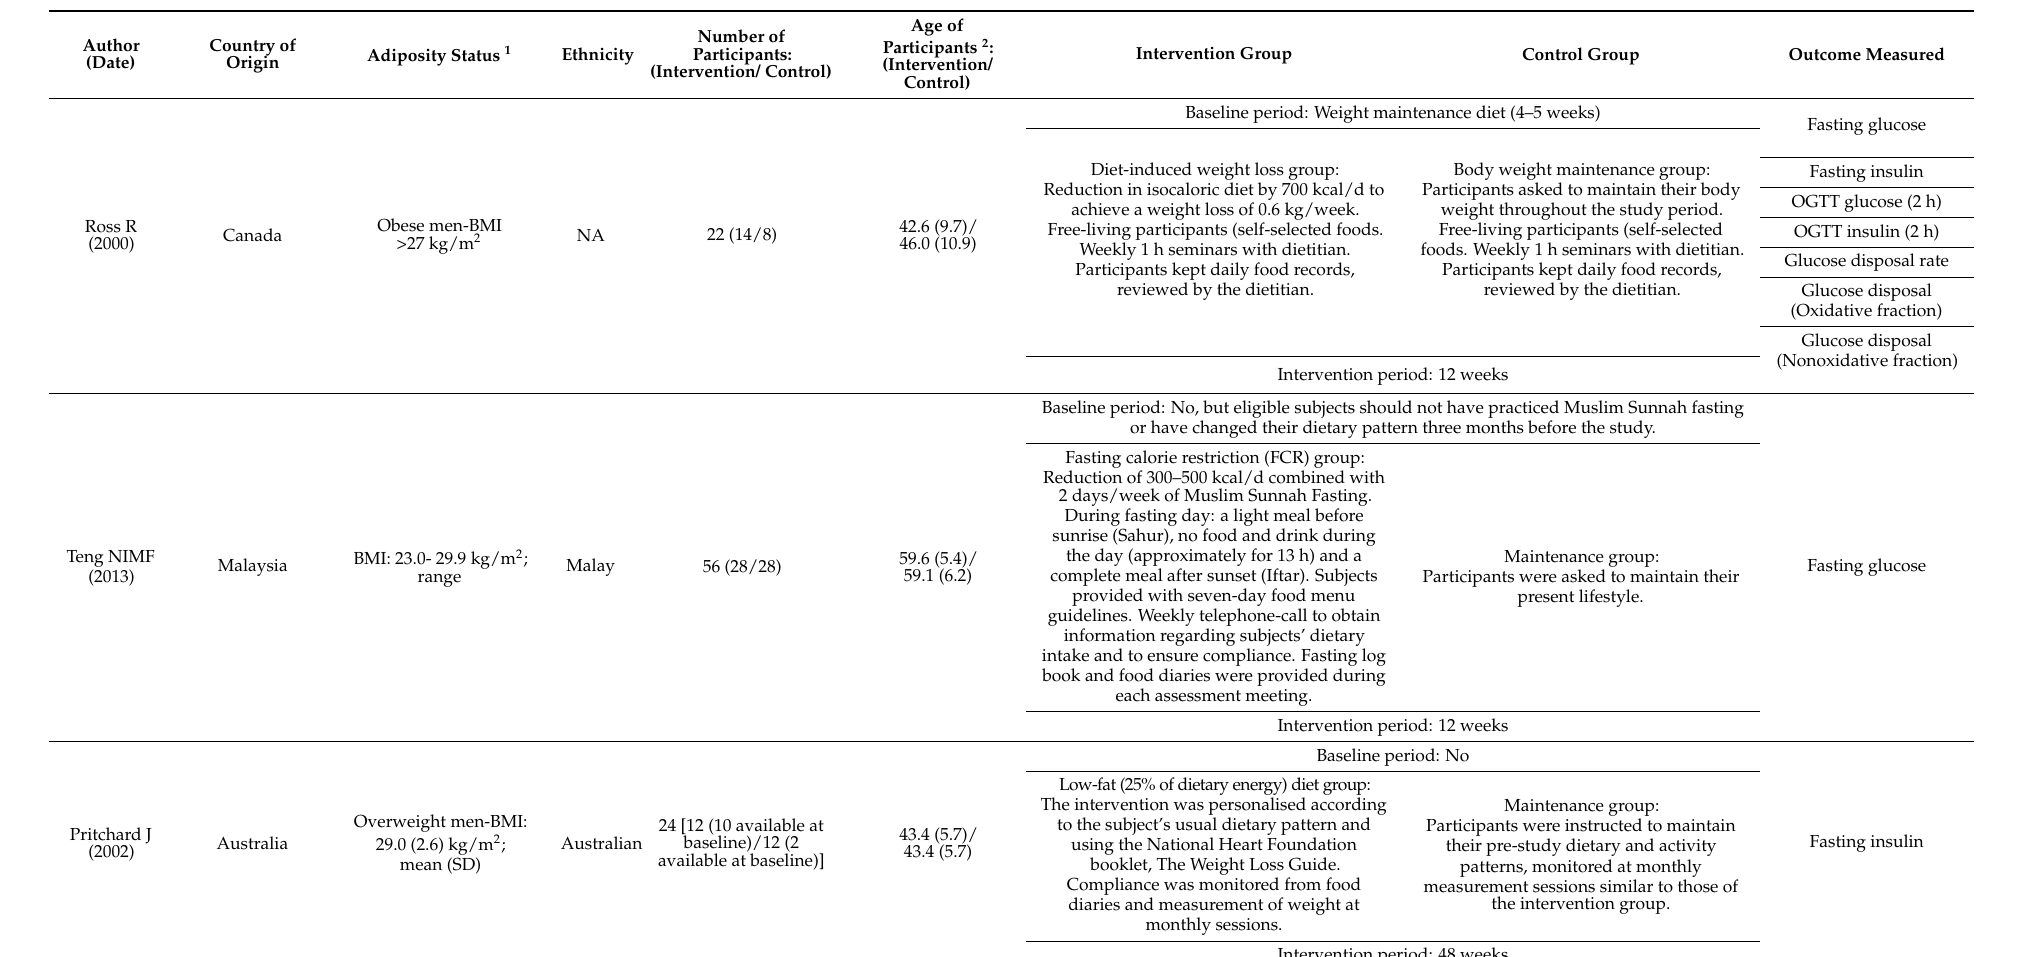
Table 1. Characteristics of included body fatness–insulin association